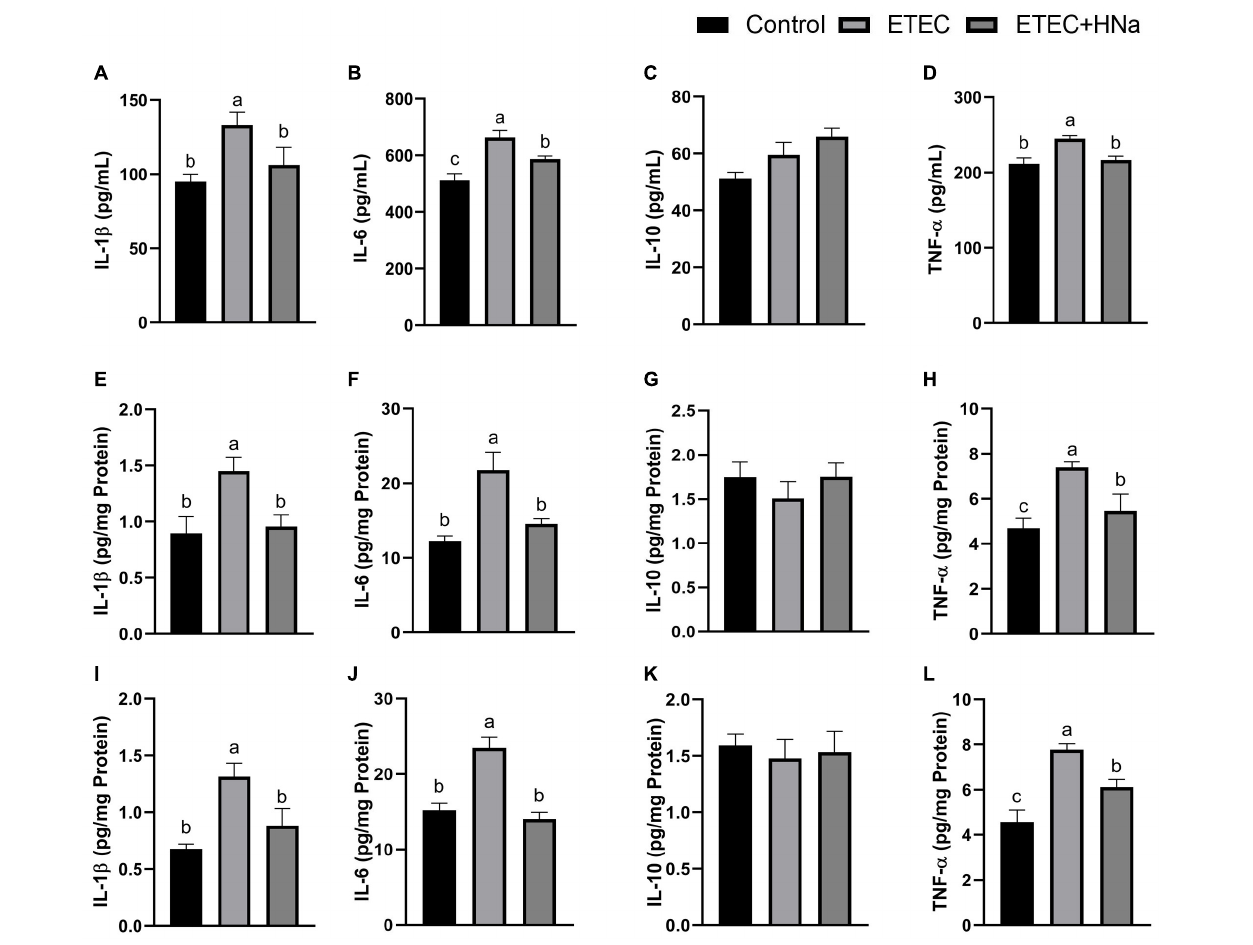
FIGURE 2 | Effects of sodium humate on the concentrations of inflammatory cytokines in serum, jejunum, and colon of ETEC K88-infected mice. Concentrations of IL-1 β , IL-6, IL-10, and TNF- α in the serum (A–D) , jejunum (E–H) , and colon (I–L) . All of the data are expressed as the mean ± SEM. Different superscript lowercase letters within each group indicate significantly different ( P <